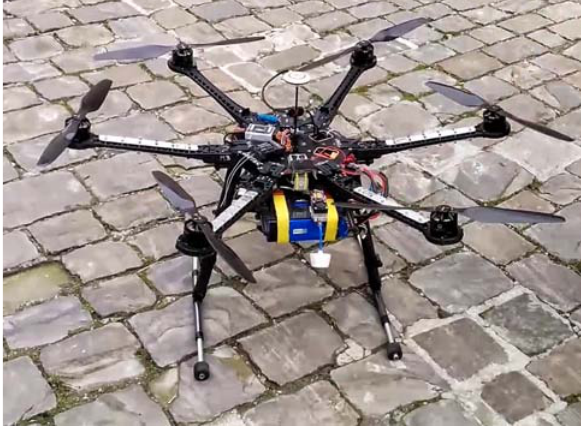
Figure 5. UAV used for surveying